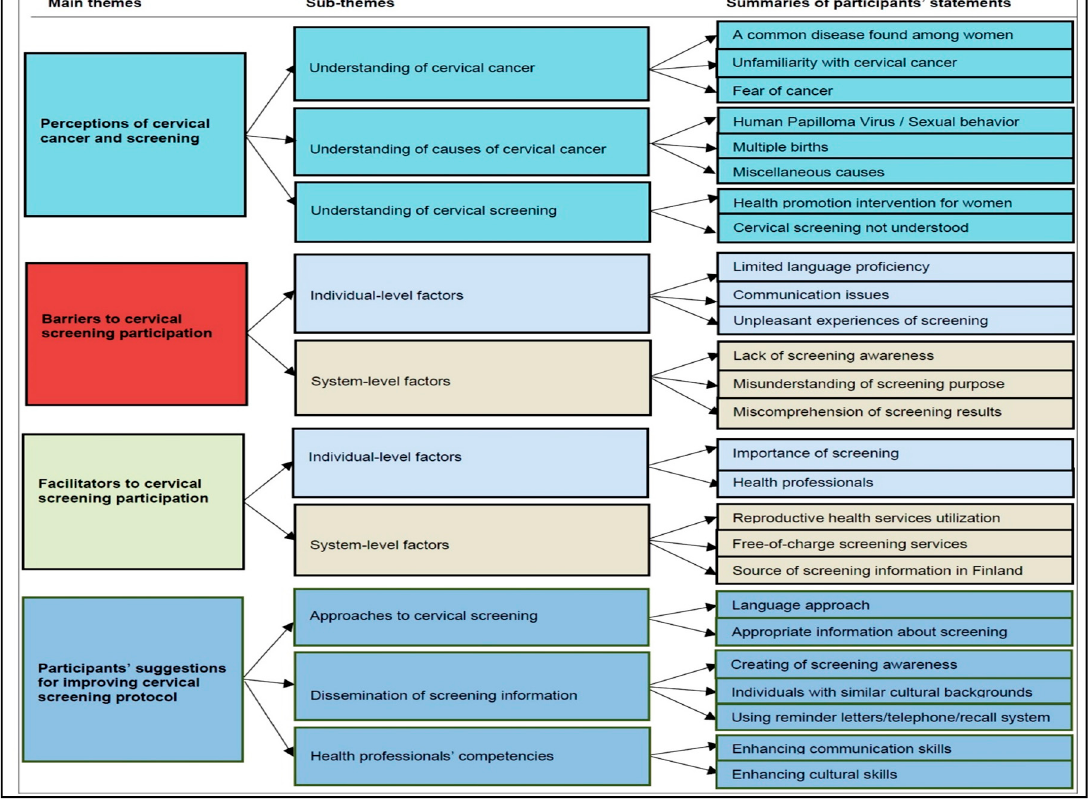
Figure 1. Summary of the main themes and subthemes emerging from the group discussions.